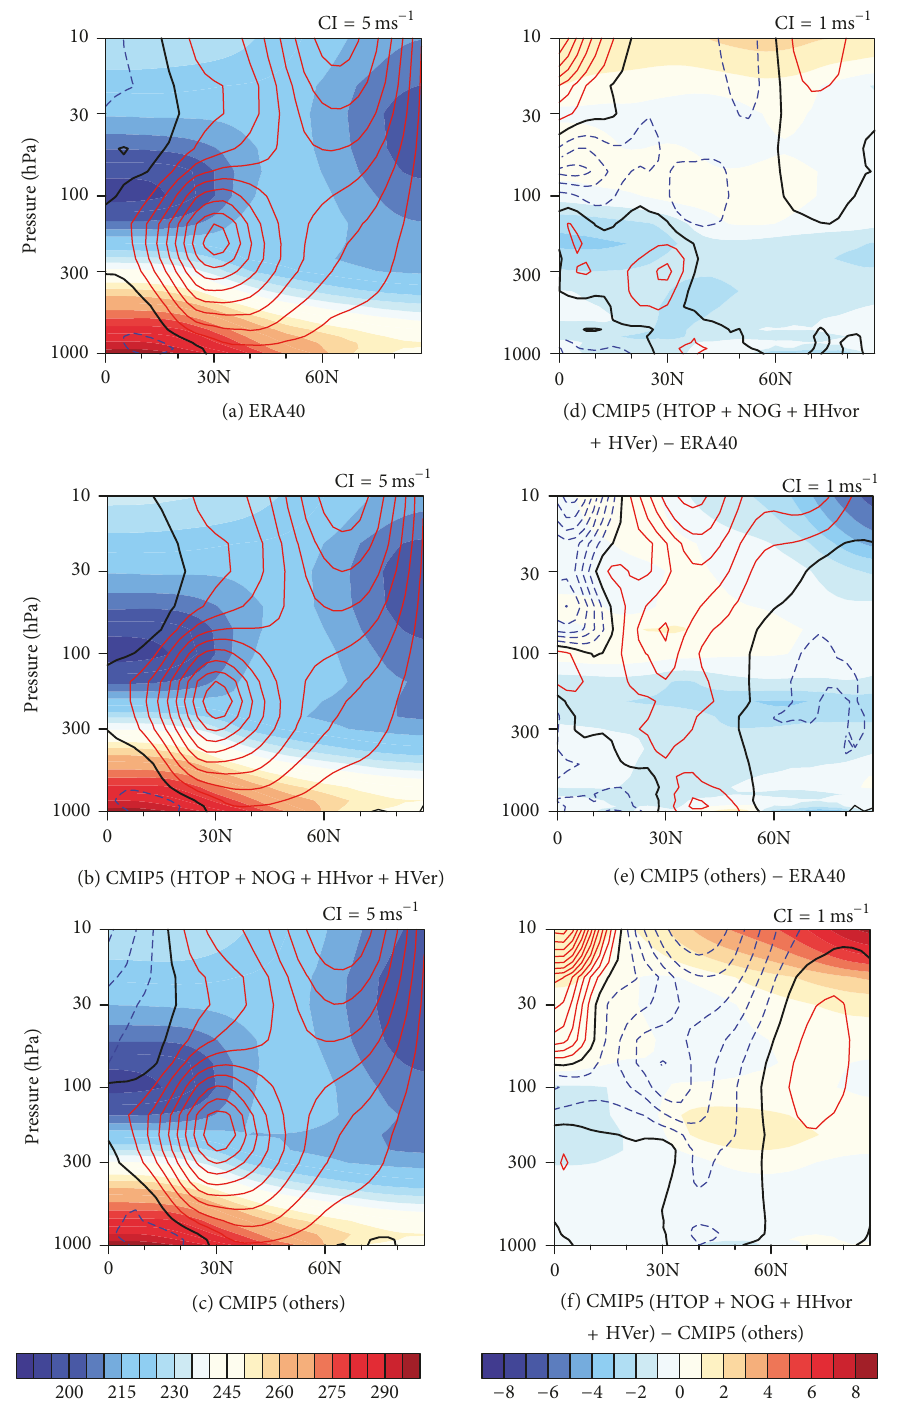
Figure 6: The 30-year climatology (left panel) and discrepancies between each ensemble (right panel) of the boreal winter (DJF) zonal-mean temperatures (shadings, unit: K) and zonal-mean zonal winds (contours, unit: ms −1 ). (a) ERA40; (b) ensemble of the 7 CMIP5 models (with HT, NOG, HVer, and HHor); (c) ensemble of the other CMIP5 models; (d) the difference between (b) and (a); (e) the difference between (c) and (a); (f) the difference between (c) and (b). The contour intervals of the left and right panels are 5m s −1 and 1ms −1 ,